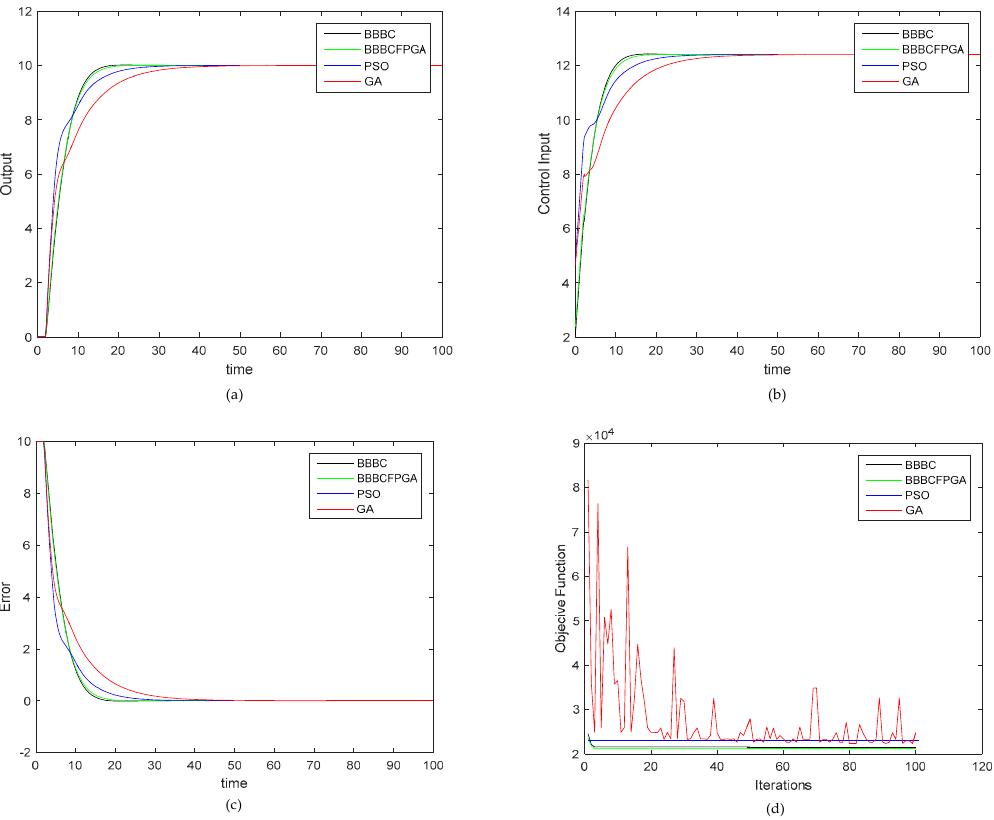
Figure 11. The ( a ) system output, ( b ) control signal, ( c ) error signal, and ( d ) objective function for all four optimization methods.